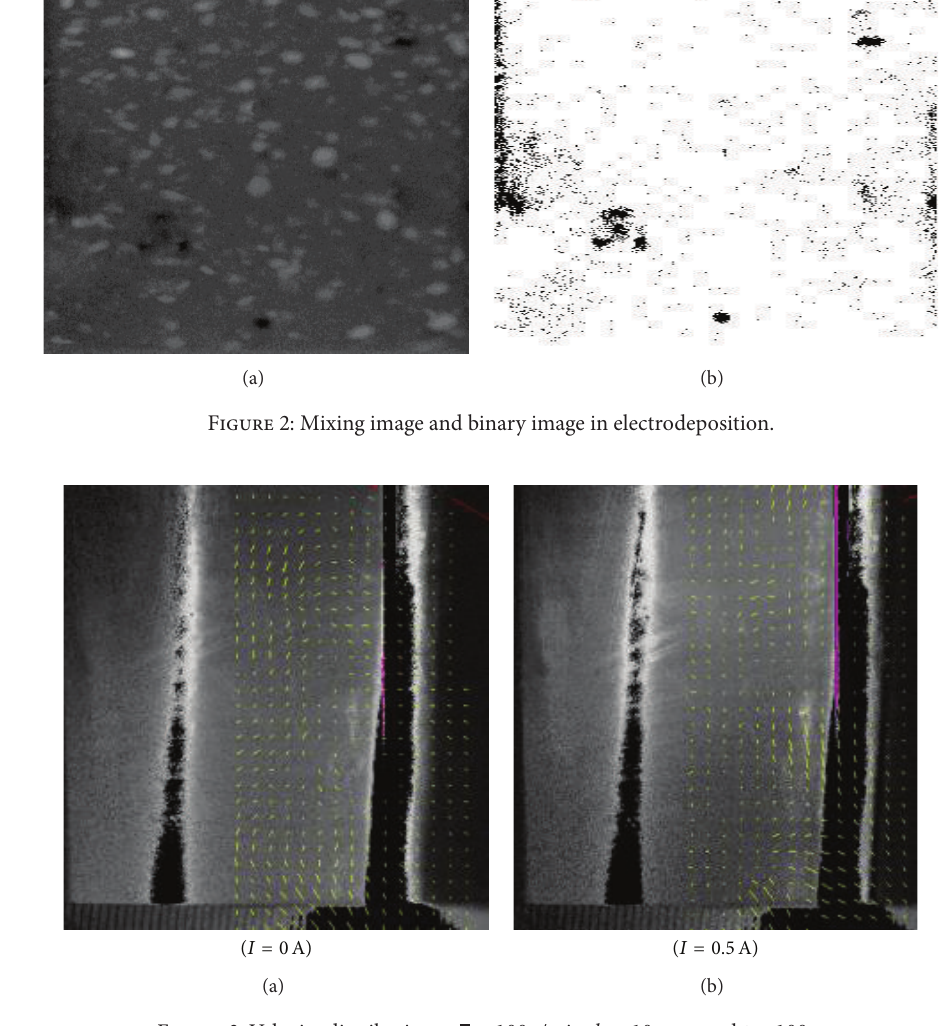
Figure 3: Velocity distribution at V = 100 r/min, ℎ = 10 mm, and 𝑡 = 100